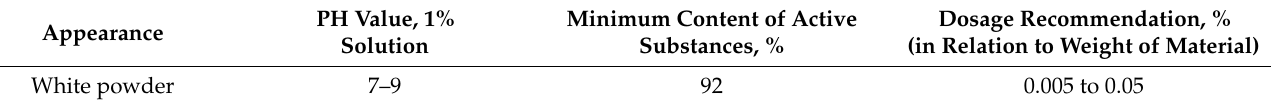
Table 4. Main characteristics of